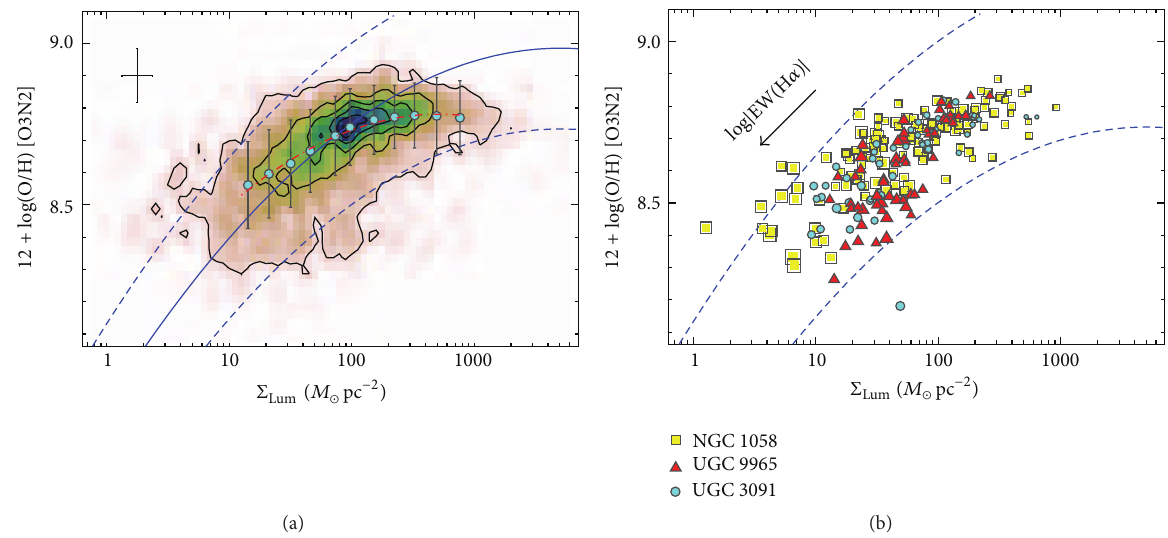
Figure 7: (a) The relation between surface mass density and gas-phase oxygen metallicity for ∼ 2000 HII regions in nearby galaxies, the local M -Z relation. The first contour stands for the mean density value, with a regular spacing of four time this value for each consecutive contour. The blue circles represent the mean (plus 1 𝜎 error bars) in bins of 0.15dex. The red dashed-dotted line is a polynomial fit to the data. The and metallicity are represented. (b) blue lines correspond to the [42] relation ( ± 0.2dex) scaled to the relevant units. Typical errors for Σ Lum Distribution of HII regions along the local M -Z relation for three galaxies of the sample at different redshifts. The size of the symbols is linked and metallicity as shown. Figure is adapted from Rosales-Ortega et al. [38]. to the value of | EW ( H 𝛼)| , being inversely proportional to Σ Lum